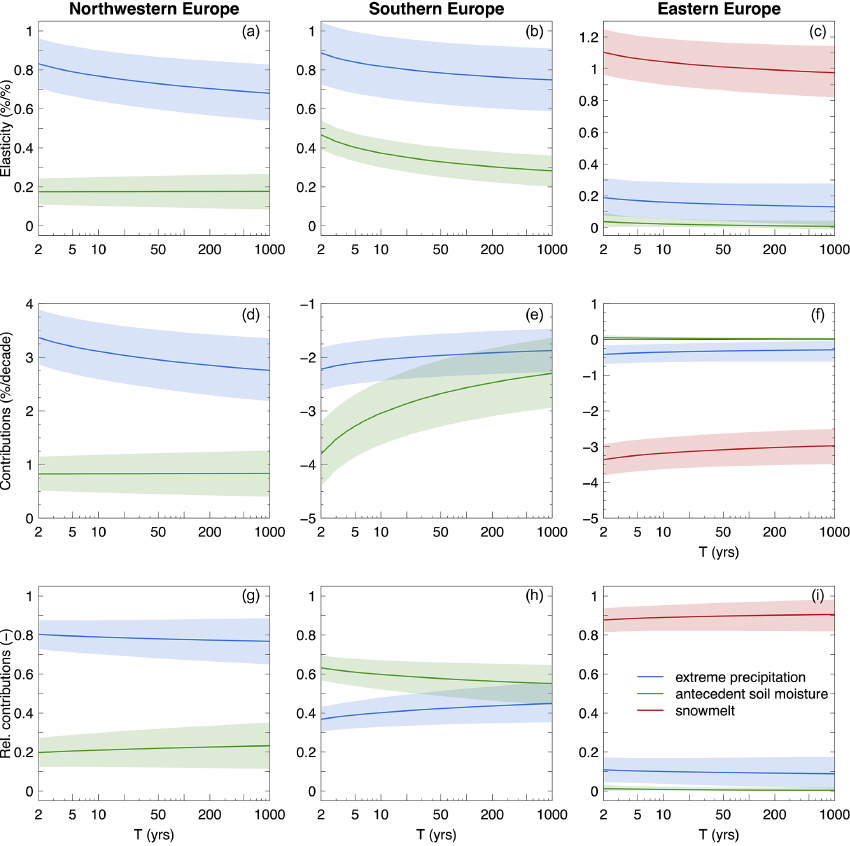
Figure 8. Contributions of drivers to flood changes as a function of the return period in three regions (columns), respectively located in northwestern, southern and eastern Europe. Elasticity of floods to the drivers (a, b, c) , contribution (d, e, f) and relative contribution (g, h, i) of the drivers to flood change are shown in the rows. The thick lines and the shaded areas represent the median and the 90% credible intervals of their posterior distributions, respectively. The results are shown for a hypothetical catchment area of 1000km 2